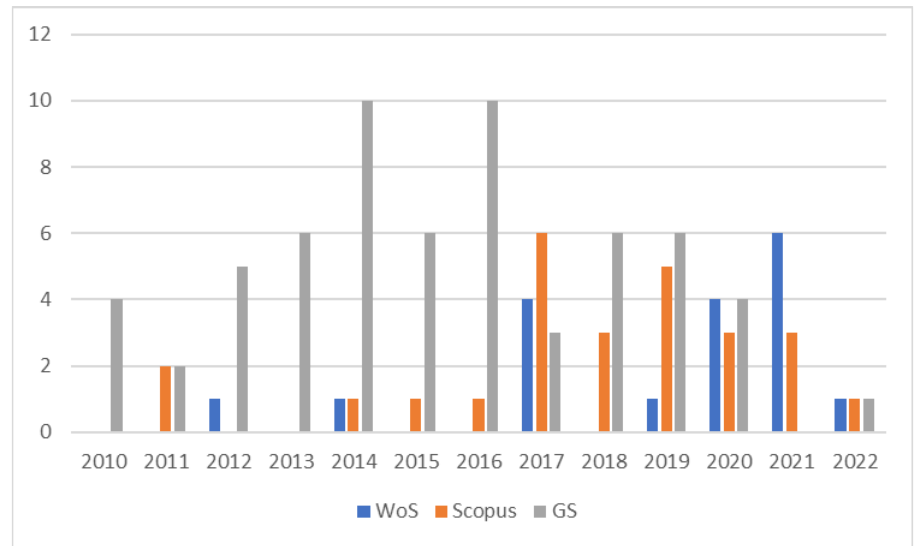
Figure 6. Development of publications per database in the study period. Source: own processing.